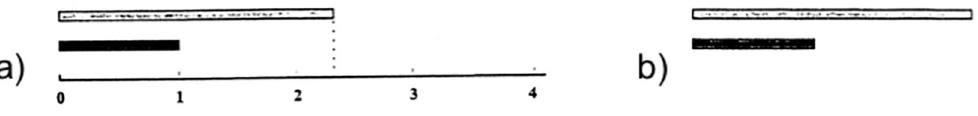
Figure 2. Adapted from Carraher (1993). Panel (a) shows a typical use of nonsymbolic quantities that are paired with natural number labels. By contrast, panel (b) shows the line segments in the same ratio and invites consideration of the relation without reliance on numbers and